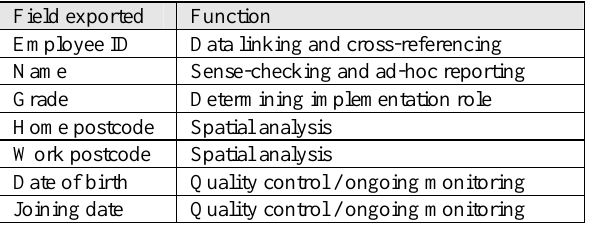
Table 1. Exported Human Resources